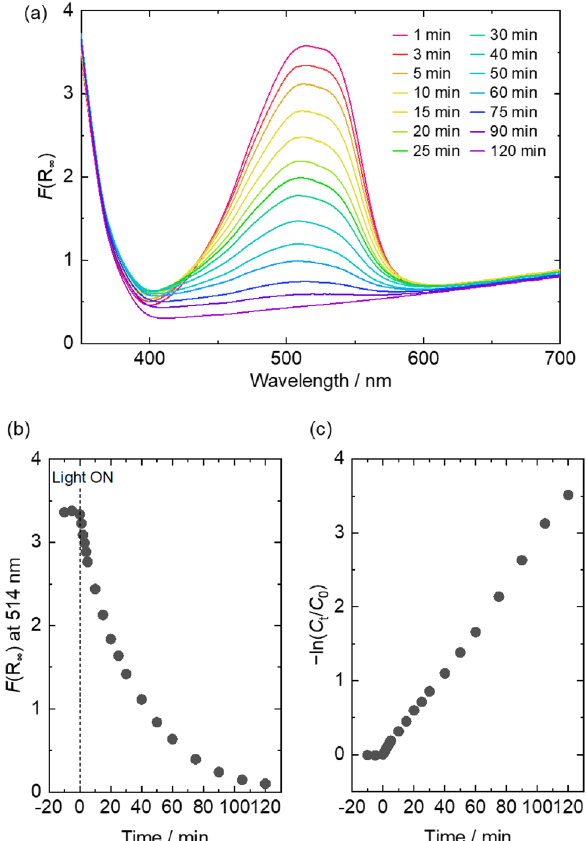
Figure 6. Decoloration of MO solution by using NTO-5–600 under VIS-light irradiation for appropriate time; ( a ) Kubelka–Munk plot, ( b ) time-dependent F (R ∞ ) decrease, and ( c ) − ln( C t / C 0 ) versus time